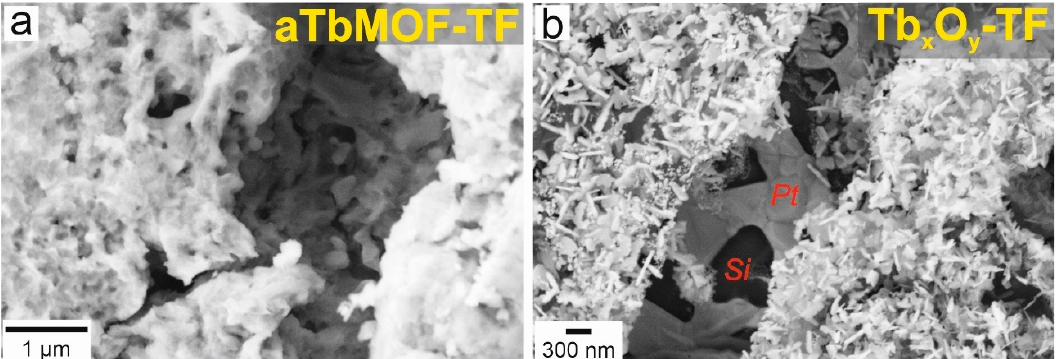
Figure 9. SEM surface microstructures of ( a ) amorphous aTbMOF-TF and ( b ) Tb x O y -TF films on Pt/SiO 2 /Si substrates (visible Pt—white and SiO 2 —black). The polycrystalline terbium oxide film differed in composition and consisted of cu- bic fluorite cF-TbO x (111), cF-Tb 2 O 3, and c-Tb 4 O 7 phases [23,24]. The Tb x O y -TF film grows by a mechanism that is analogous to the Stranski–Krastanov mechanism in that single